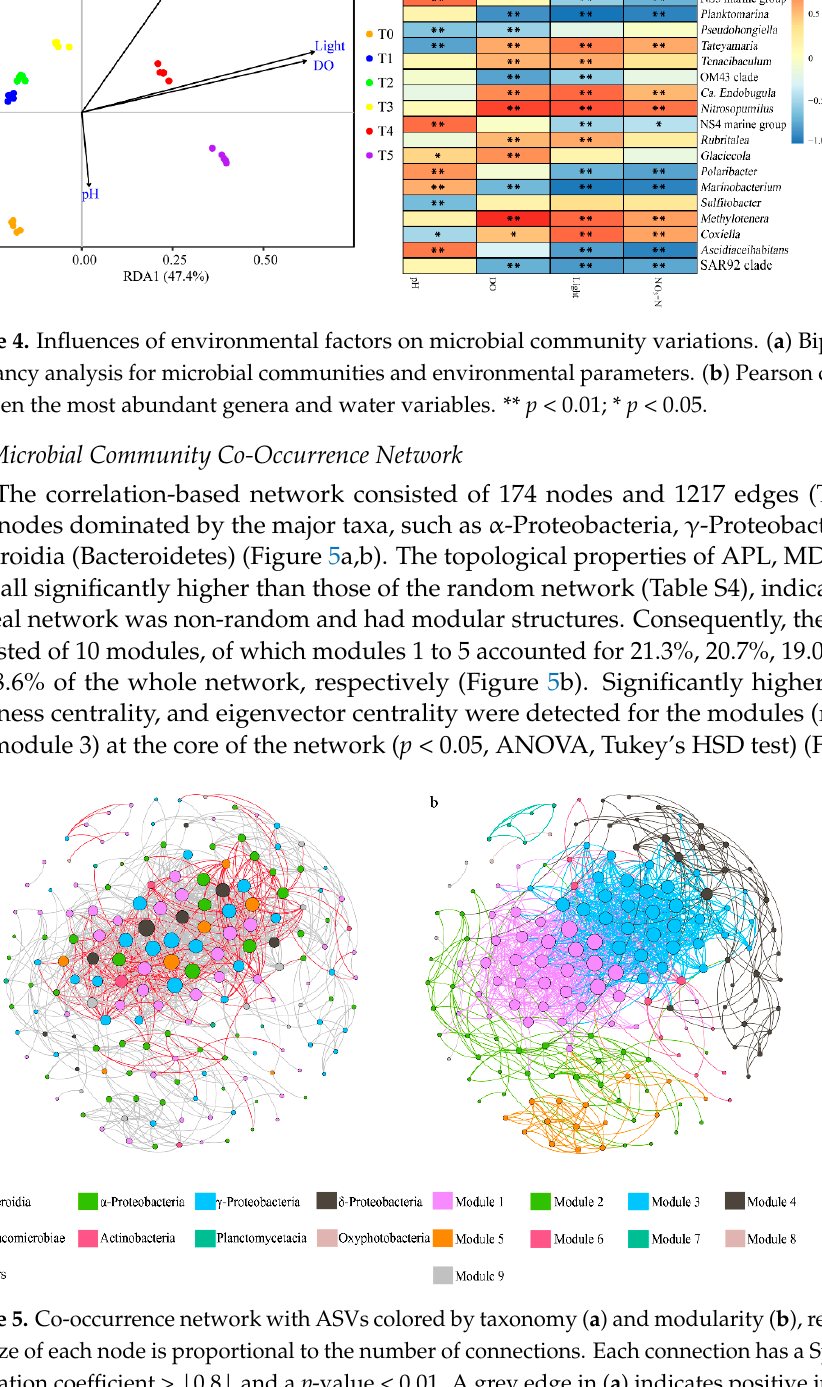
Figure 6. Comparisons of topological parameters among the prevalent modules within the net- work. ( a ) Degrees; ( b ) Betweenness centrality; ( c ) Closeness centrality; ( d ) Eigenvector centrality. The letters above the boxes represent significant differences among modules determined by ANOVA with a Tukey’s HSD test. 4. Discussion 4.1. Microbial Diversities during the Seedling Production Stage In the present study, microbial communities were determined, which dramatically changed over time with a notable separation between sampling time points and a dissim- ilarity turnover rate >0, indicating that planktonic microbial community changed during the course of kelp seedling production. The dynamic was also determined for alpha diversity. It is shown that microbial rich- ness (observed bacterial/archaeal species) negatively correlated with the slowly decreased temperature, contrasting with previous reported positive correlations, notably below 20 °C [49–51]. The only driving force could be attributed to the growth of the kelp seedlings